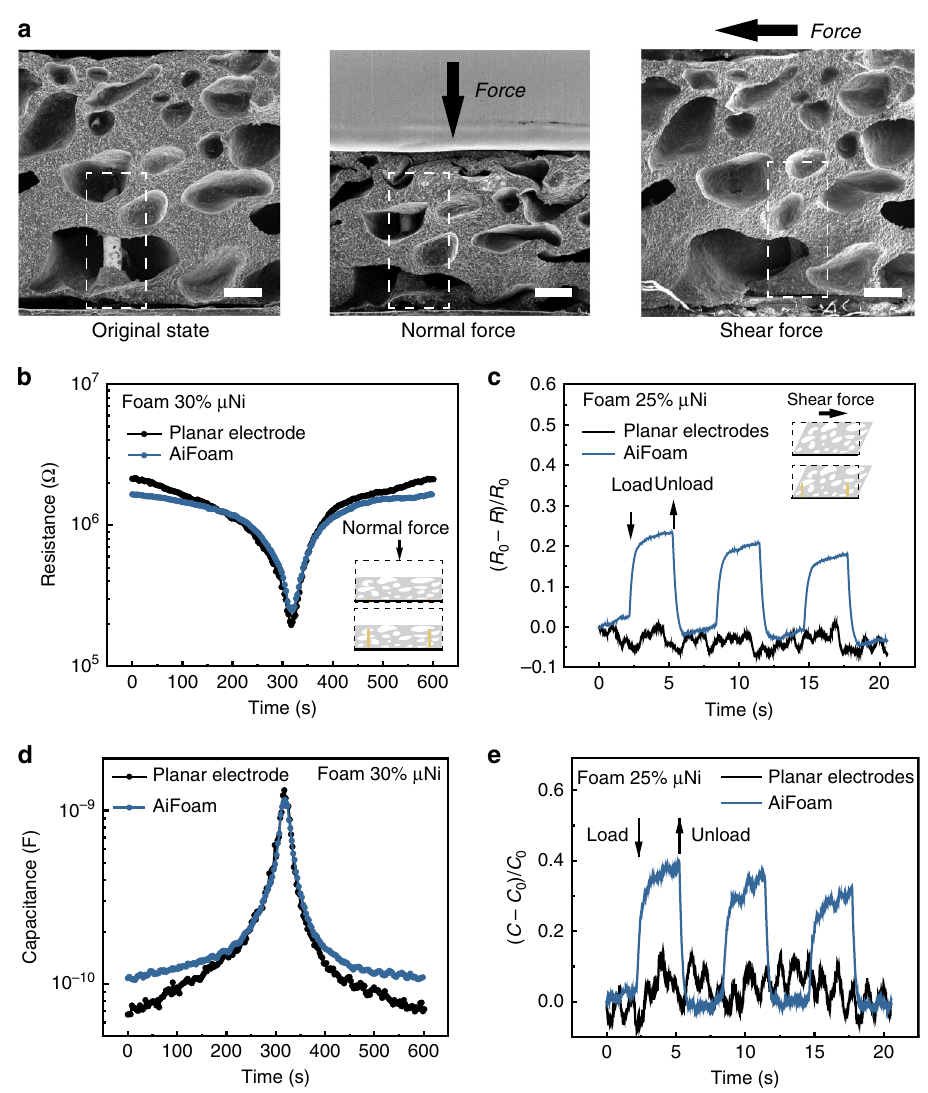
Fig. 2 Arti fi cial innervation for normal and shear-force detection of AiFoam. a SEM images of AiFoam sensor with 3D electrodes, revealing the original state ( left ), normal-force loading state ( middle ) and shear-force loading state ( right ), respectively. The black arrows represent the applied force directions. The dotted white boxes show the relative deformation of foam material to the 3D copper electrode. Scale bar: 200 μ m. b Resistance and d capacitance responses on applying the normal force of 15 N to the Aifoam (with 30 vol% μ Ni) and control with 2D planar electrodes. Note that the data of b and d were simultaneously collected. c Resistance change and e capacitance change responses on applying the shear force to the AiFoam (with 25 vol% μ Ni) and control with 2D planar electrodes. Note that the data of c and e were simultaneously collected. R 0 and C 0 represent the initial resistance and capacitance of the sensor, whereas R and C represent the resistance and capacitance of the sensor during the pressure